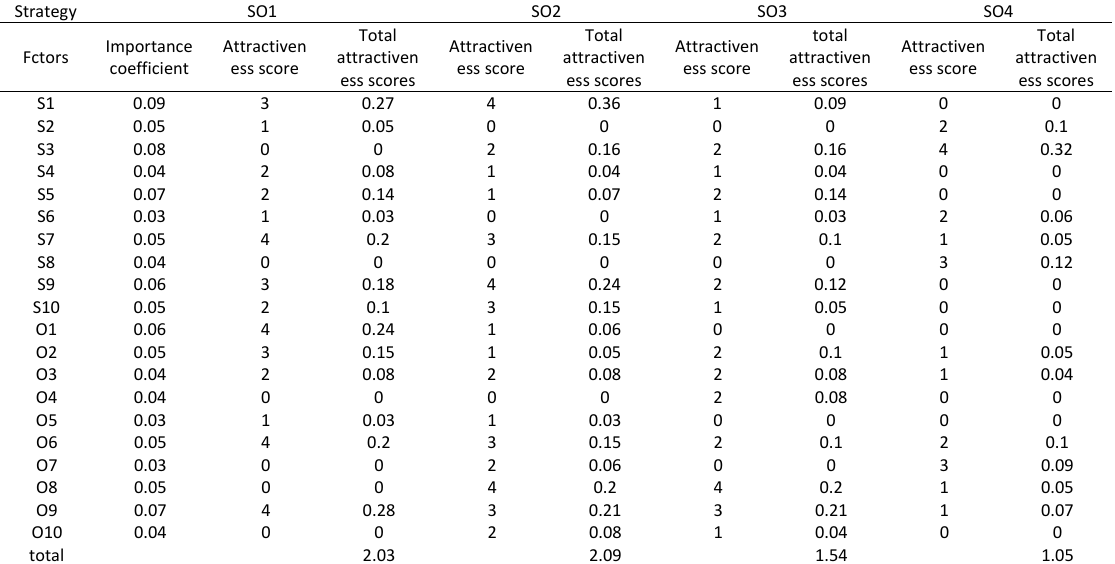
Table 5. QSPM of SO